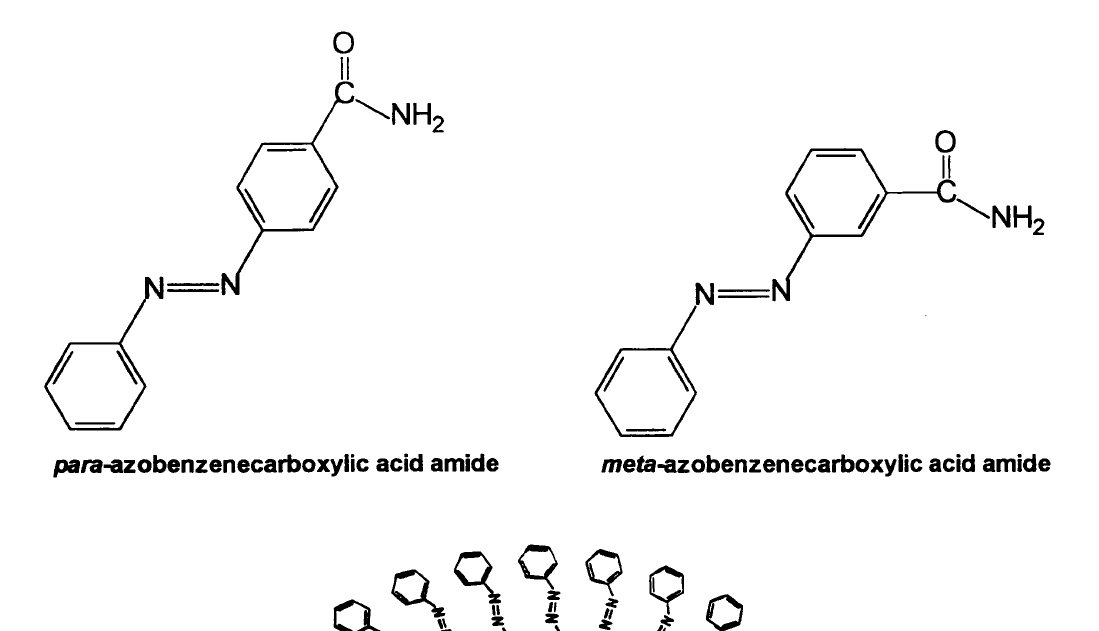
An. Acad. Bras. Ci. ,(2000) 72